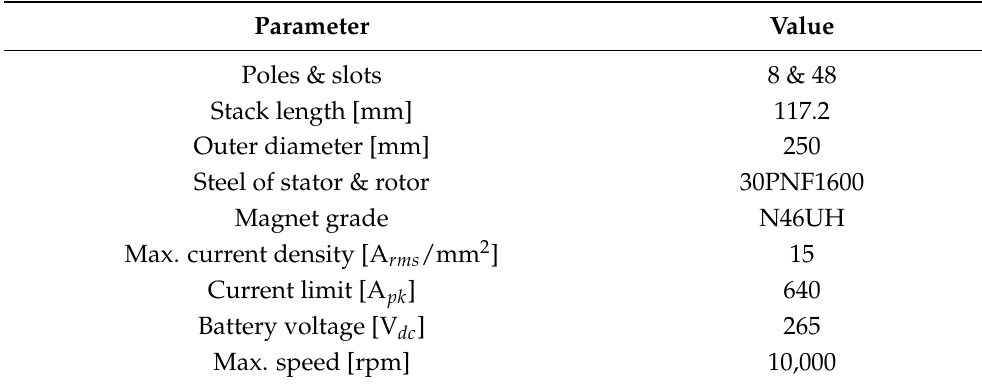
Table 1. Design specification of analyzed motor.